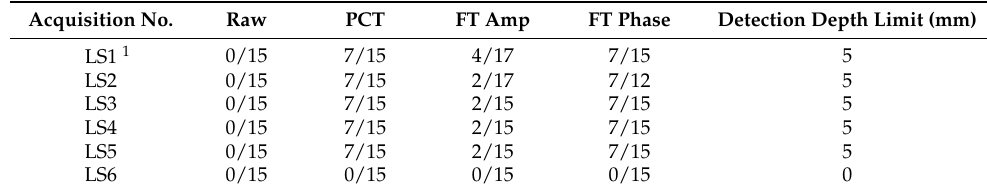
Table 11. Optical lock-in results from the inspection of the CF-PET-CF sandwich sample. Acquisition No.